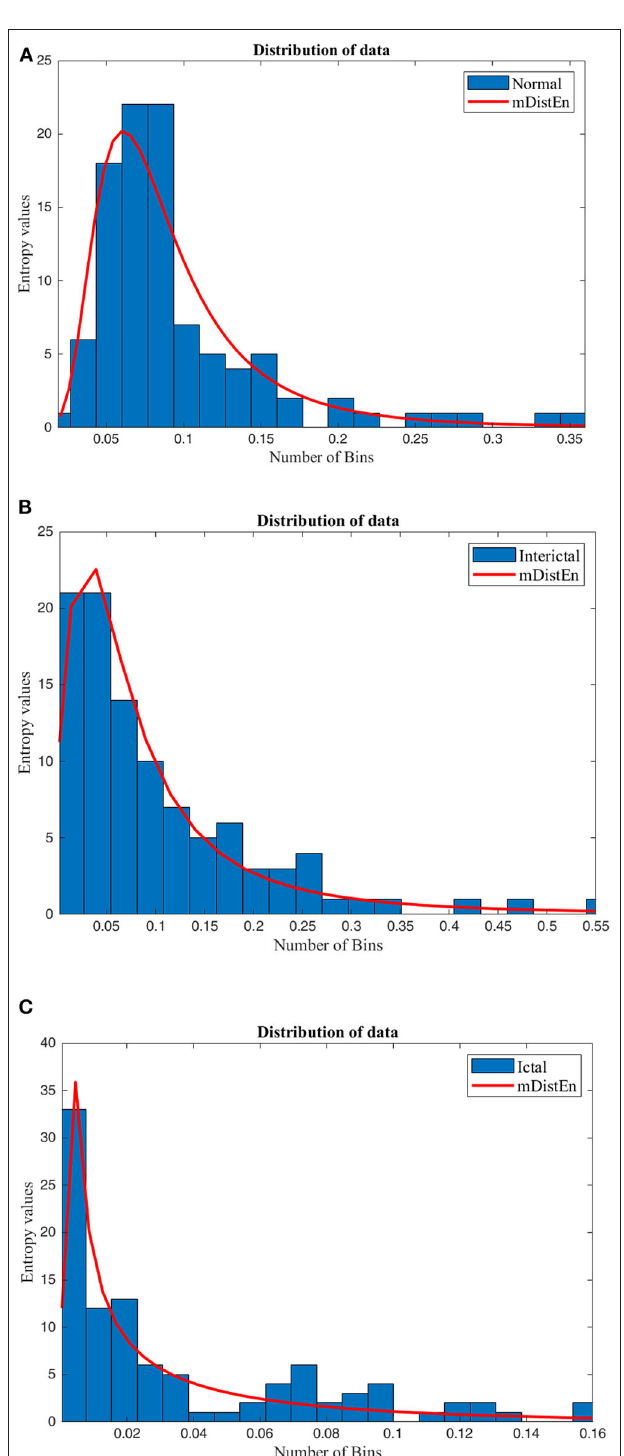
FIGURE 3 | Distribution of the data. The mDistEn is calculated using (A) normal EEG datasets A and B and its distribution, (B) the interictal datasets C and D and its distribution, and (C) ictal dataset E and its